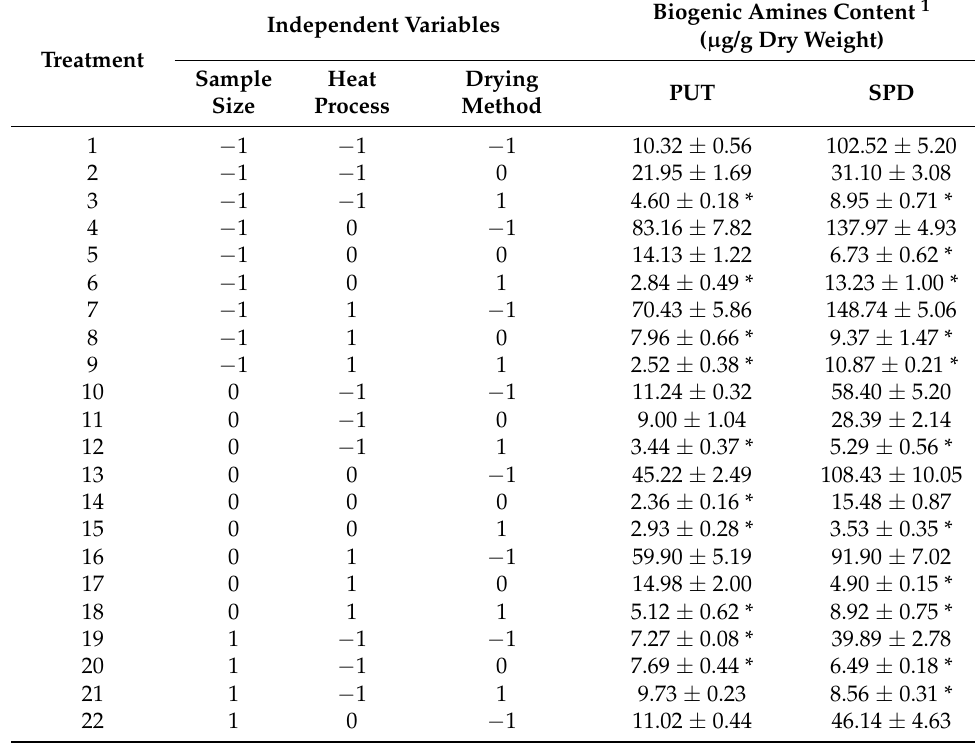
Table 4. The factorial experimentations of the three factors for the contents of the biogenic amines ( µ g/g dry weight) in the H. erinaceus